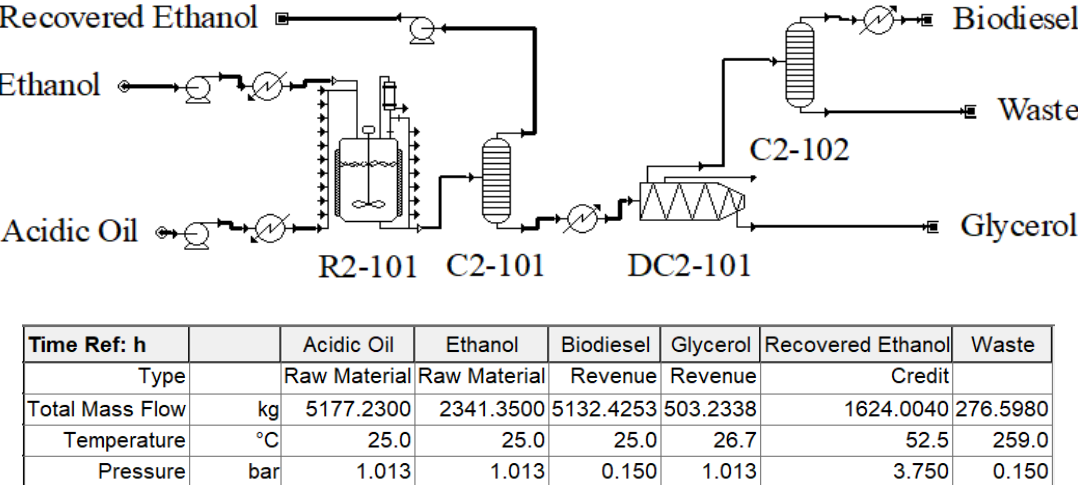
Figure 2. Technology option II: R2-101 CSTR for the production of biodiesel, C2-101 first short cut distillation column to recover excess ethanol, DC2-101 centrifugal decanter to separate the glycerol, and C2-102 second short cut distillation column to purify the biodiesel.